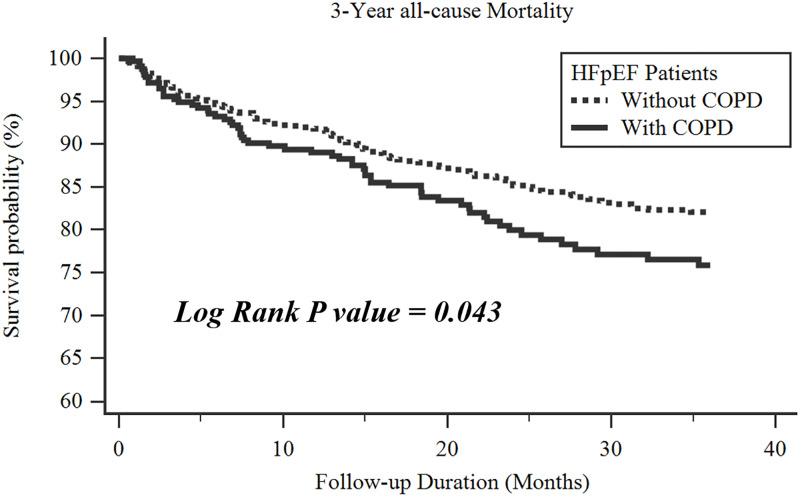
The Kaplan–Meier survival curve analysis of the study population, stratified by the presence of chronic obstructive pulmonary disease.